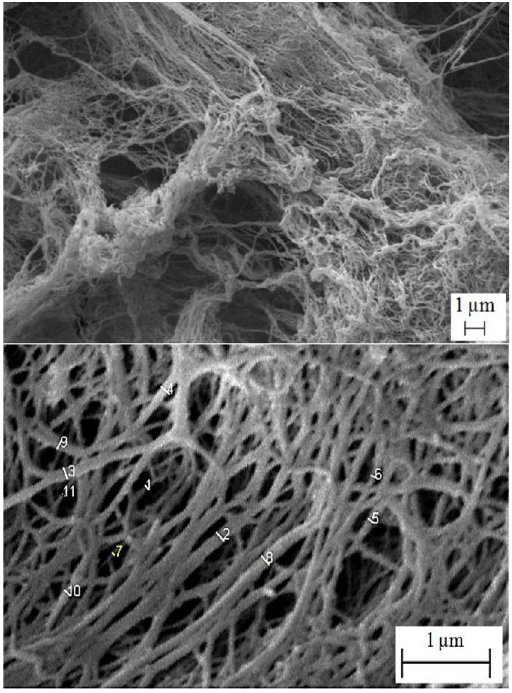
Fig. 2. SEM image of paclitaxel loaded BSM aerogel obtained at 50 ºC, CO flow rate of 3 mL/min, 20 MPa, ethanol concentration 2 of 7.5% and DMSO/water ratio of 6 (v/v) with the magnitude of a) 10000X and b)